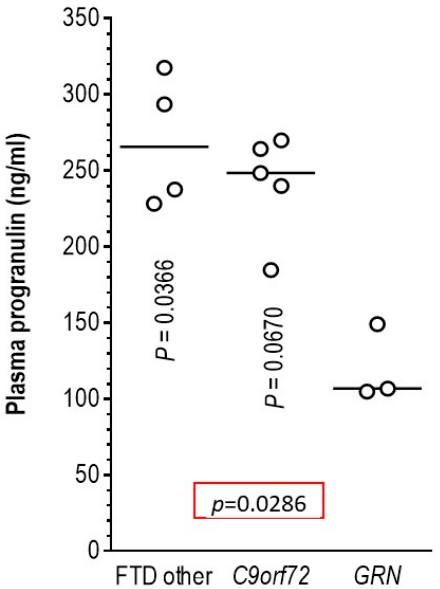
Figure 6. Association of GRN pathogenic variants with plasma progranulin levels. Lower plasma progranulin levels were found in the 3 FTD patients with the GRN variants (c.463-2A>G, c.934-1G>A and p.Cys482Tyr) compared to FTD patients harboring the C9orf72 repeat expansion and to other FTD patients.